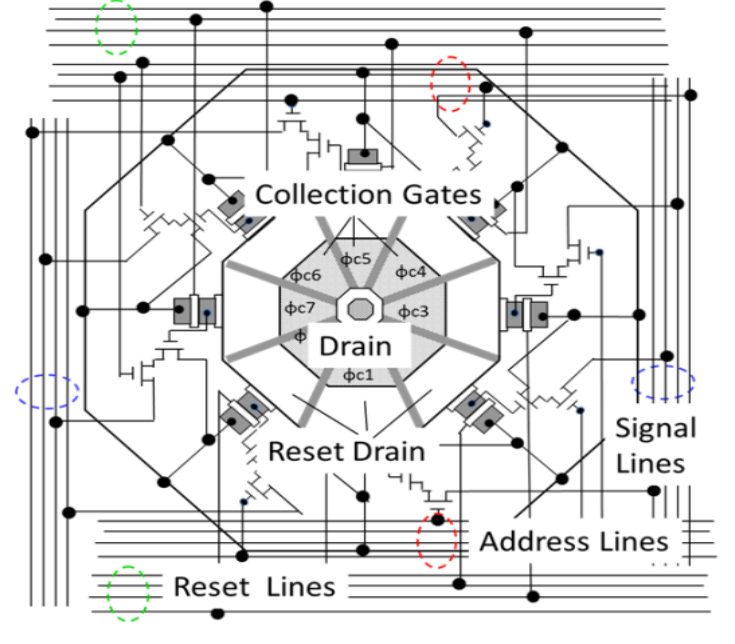
Figure 8. An octagonal CMOS multi-collection-gate image